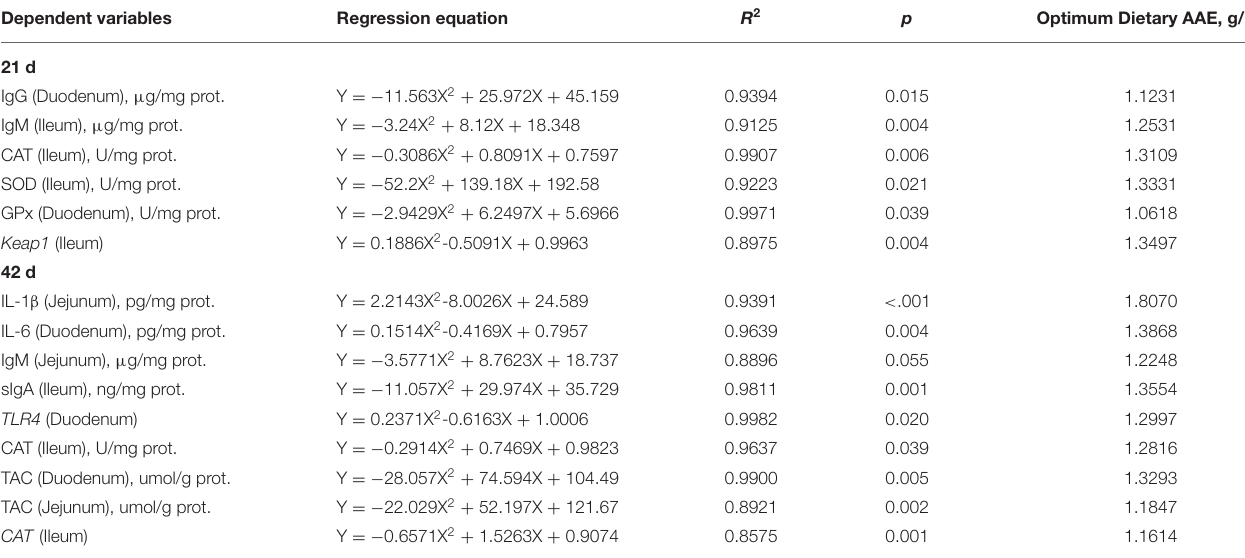
TABLE 4 | Estimation of the extremum response for dietary AAE levels based on quadratic regressions in broilers. Dependent variables Regression equation R 2 p Optimum Dietary AAE,